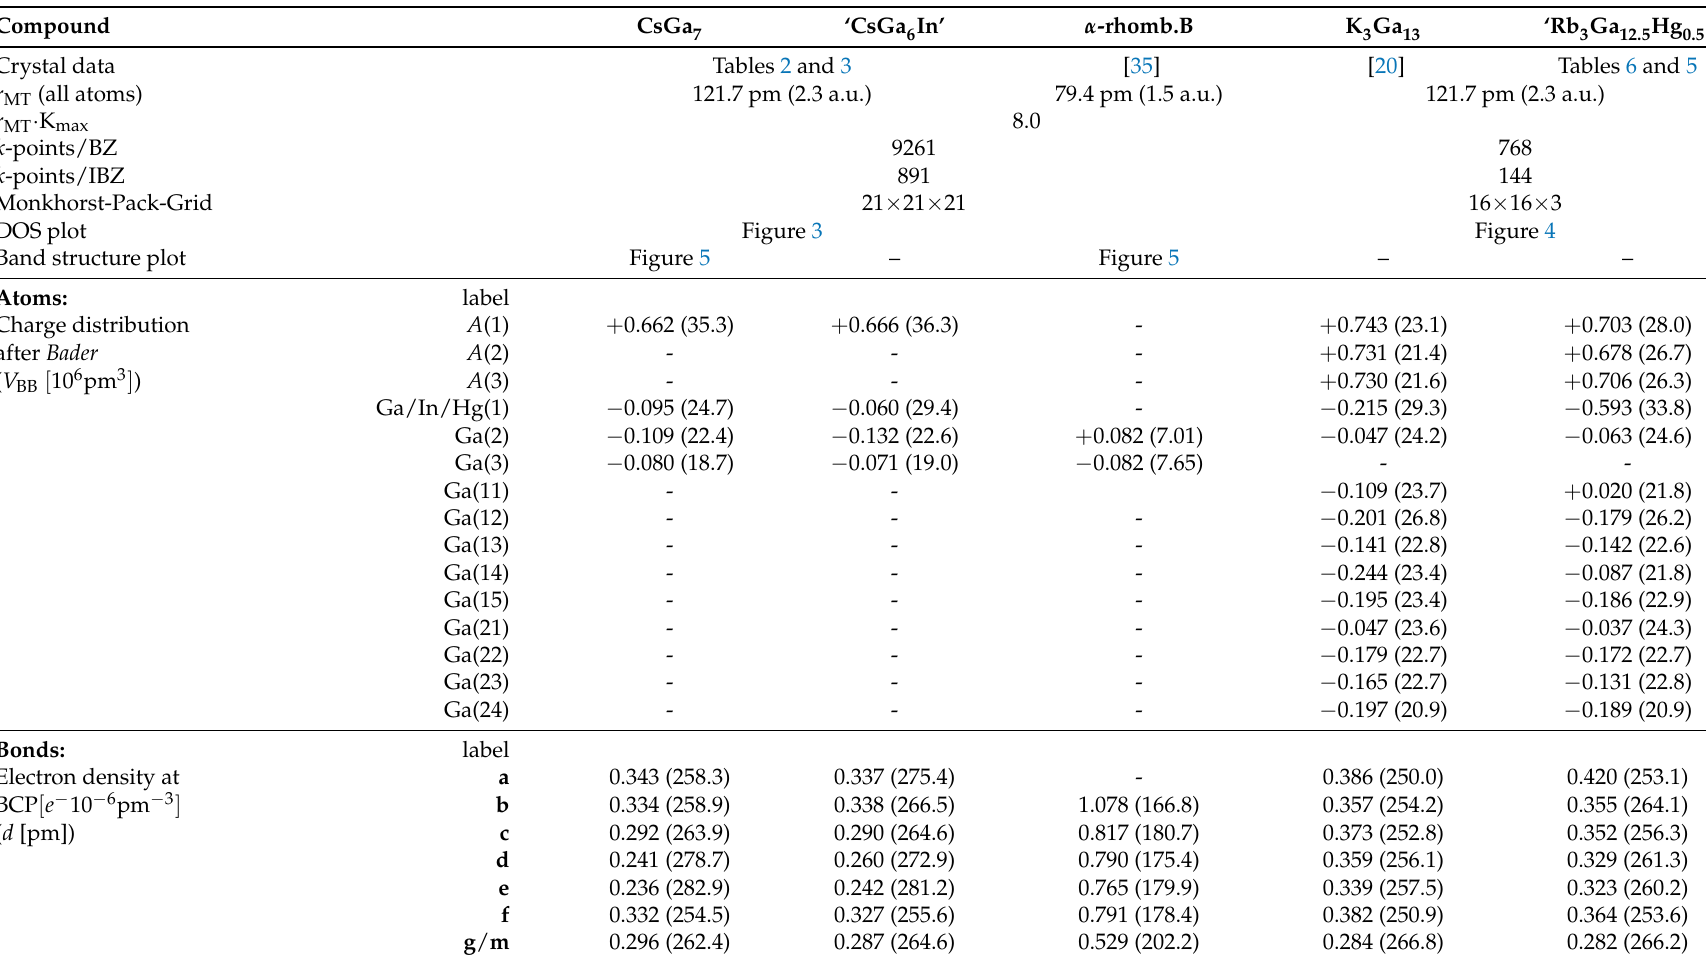
Table 9. Details of the calculation of the electronic structure of the binary alkali trielides CsGa PWin the interstitium; BCP: bond critical point; IBZ: irreducible part of the Brillouin zone; V BB : volume of the Bader basins; d : bond